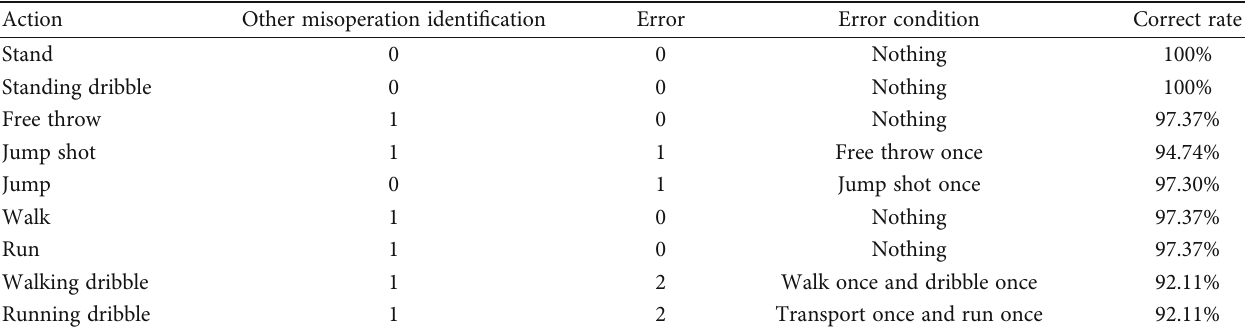
Table 7: Recognition accuracy of ipsilateral placement mode of object set identi fi ed by decision